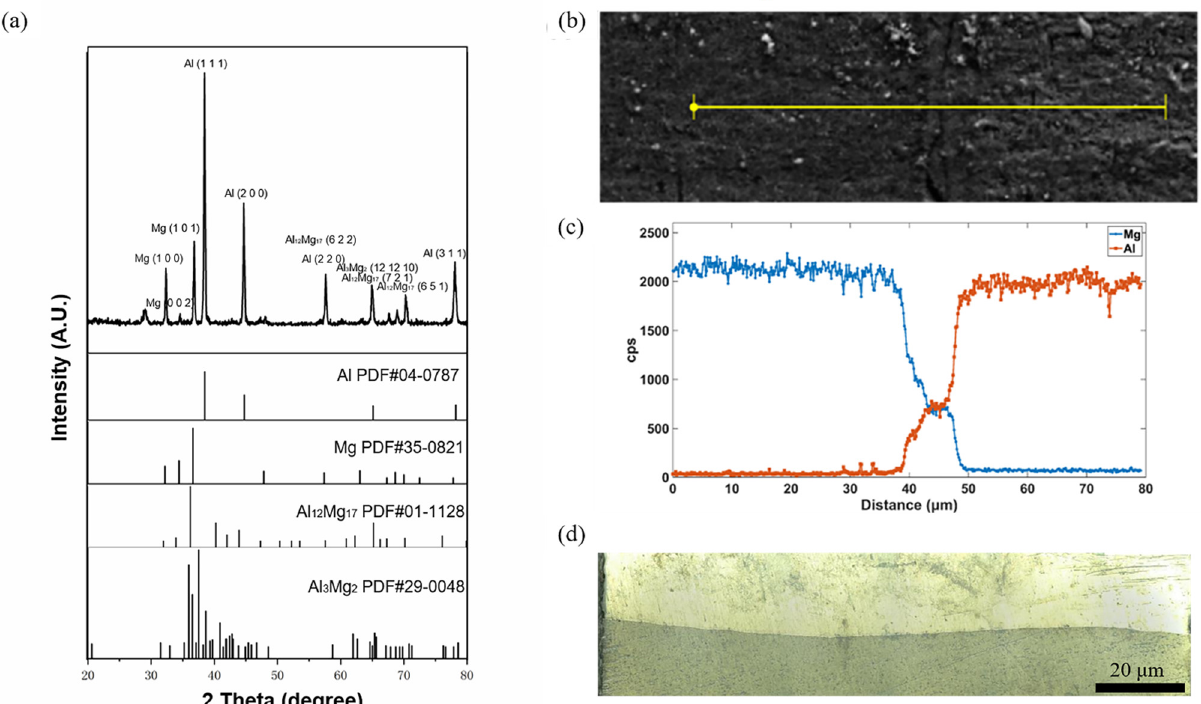
Figure 3. Interface properties of Mg/Al corrugated composite plate: ( a ) XRD patterns; ( b ) position of line scan by SEM; ( c ) content of Mg and Al by EDS; ( d ) interface morphology.